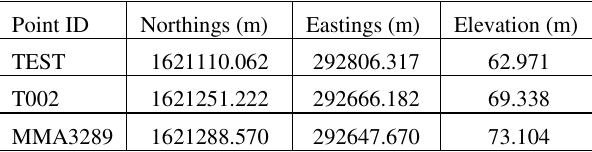
Table 5. Values of coordinates of the test